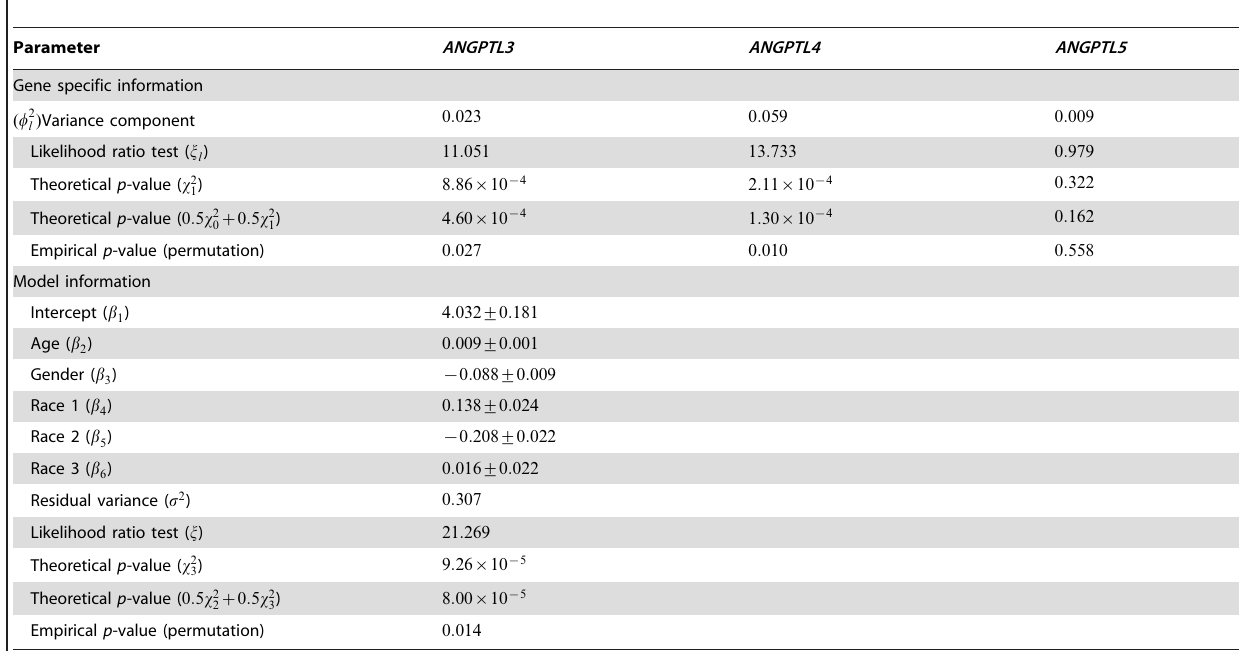
Table 3. Parameters of three genes of the Dallas Heart Study estimated jointly using the ARR method proposed in this study.